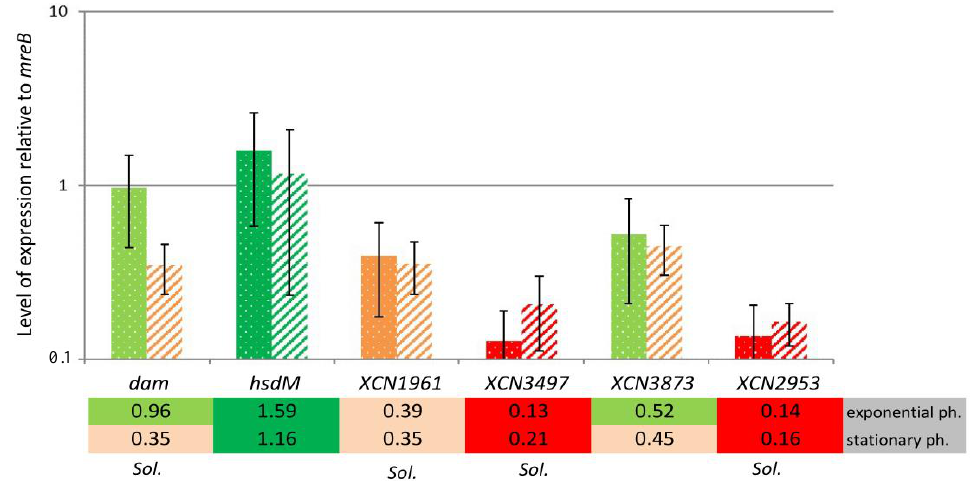
Figure 3. Expression level of the 6 MTases-encoding genes in X. nematophila F1. The expression ratio of each MTase gene relative to the mreB housekeeping gene is indicated. Measurements were performed on RNA extracted from 3 independent experiments during growth in exponential (dotted bars) or stationary (hatched bars) phase. Various colors represent various ranges of level of expression. Green, >1-fold the mreB gene; light green, >0.5-fold the mreB gene; orange, >0.3-fold the mreB gene; red, <0.3-fold the mreB gene. sol. : solitary